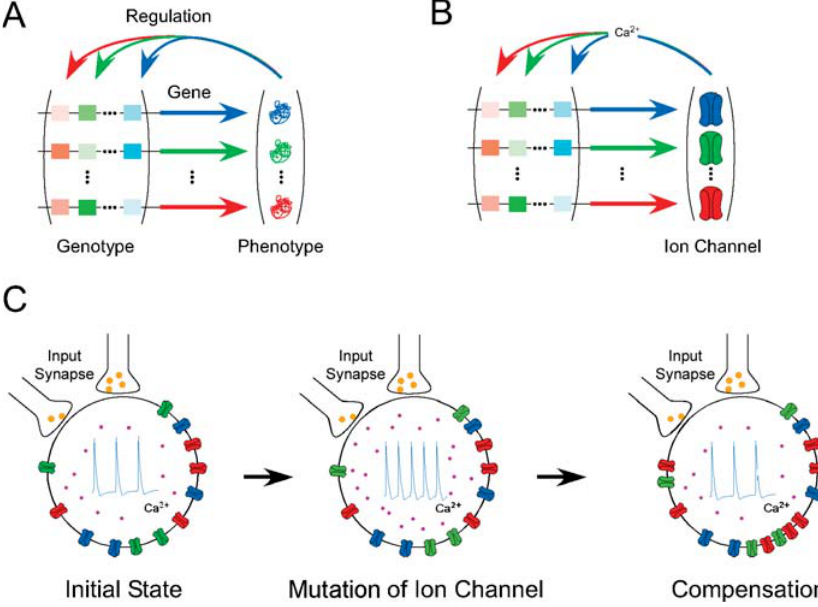
DOI: 10.1371/journal.pbio.0020019.g001 Figure 1. Similarity between a Gene Network Acting as an Evolutionary Buffer and a Gene Network Regulating Neuronal Ion Channel Expression (A) Each gene (horizontal arrow) is regulated by the products of the other genes by means of upstream enhancer elements (boxes). The strength and direction of regulation (depicted as different colour saturation levels) are a function of both the upstream element and the abundance of its corresponding gene product. (B) A similar representation of a putative network for activity-dependent ion channel regulation in a neuron in which Ca 2+ concentration acts as a feedback mechanism. (C) The mechanism of ion channel compensation in a neuron. The activity of the neuron is dependent upon its synaptic inputs and the suite of ion channels it expresses. Mutation of a gene encoding an ion channel leads to a change in the properties of that channel (depicted as a change in colour saturation) and hence to an increase in activity and internal Ca 2+ (purple). These changes induce a compensatory increase in the expression of another ion channel (red) to restore the original level of